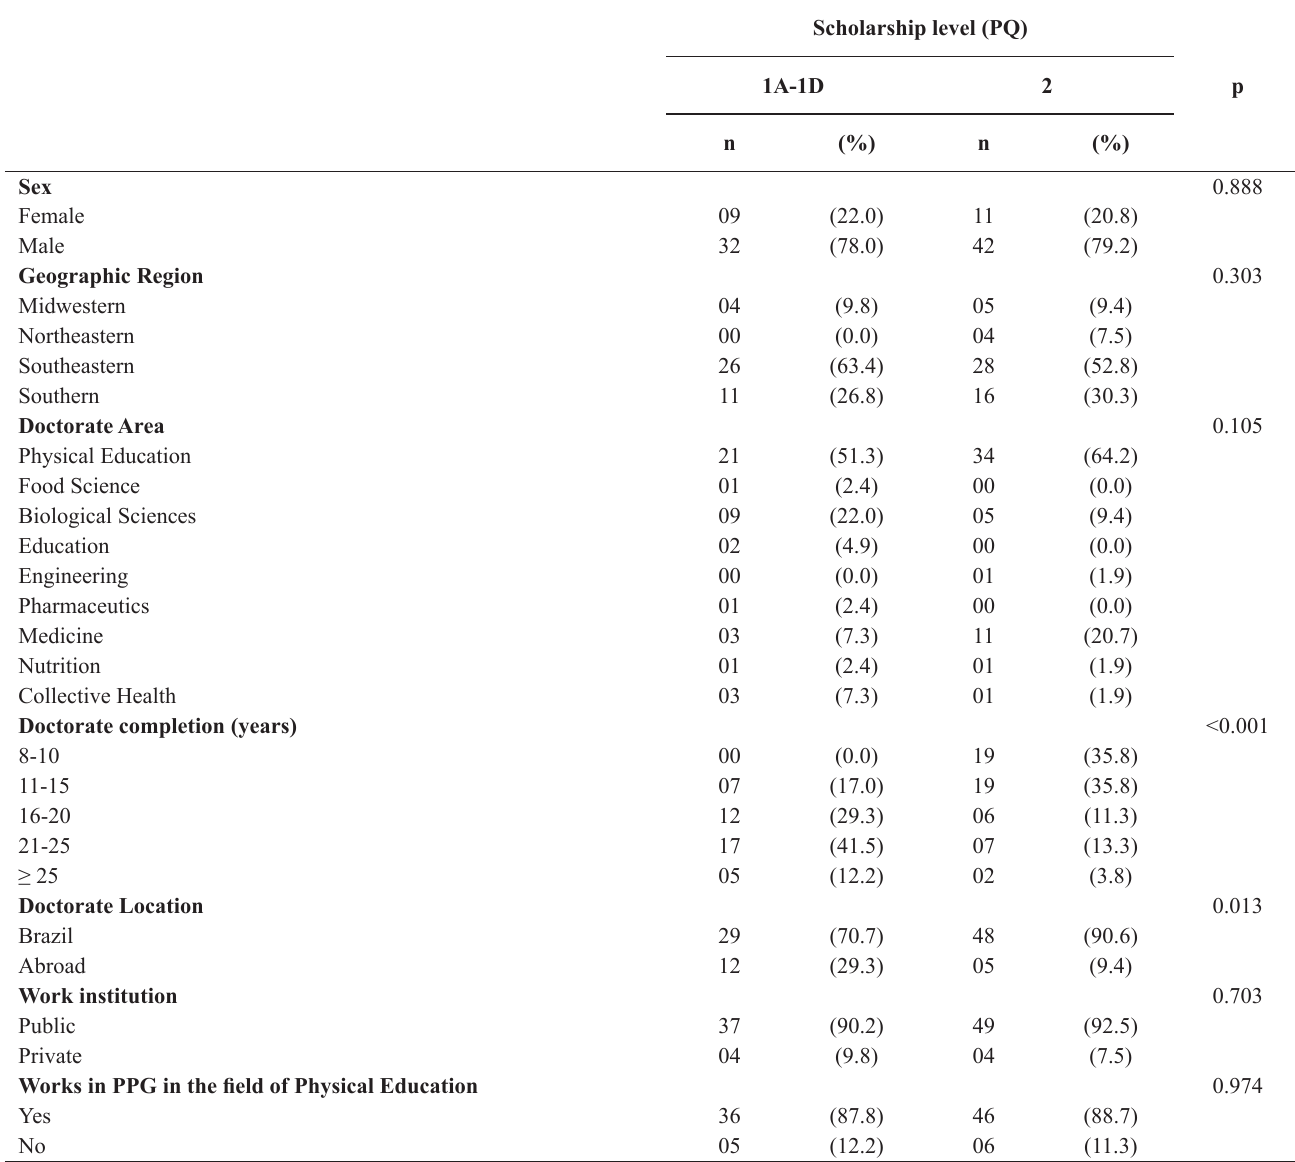
Table 1 - Distribution of CNPq Productivity Researchers in the field of Physical Education,